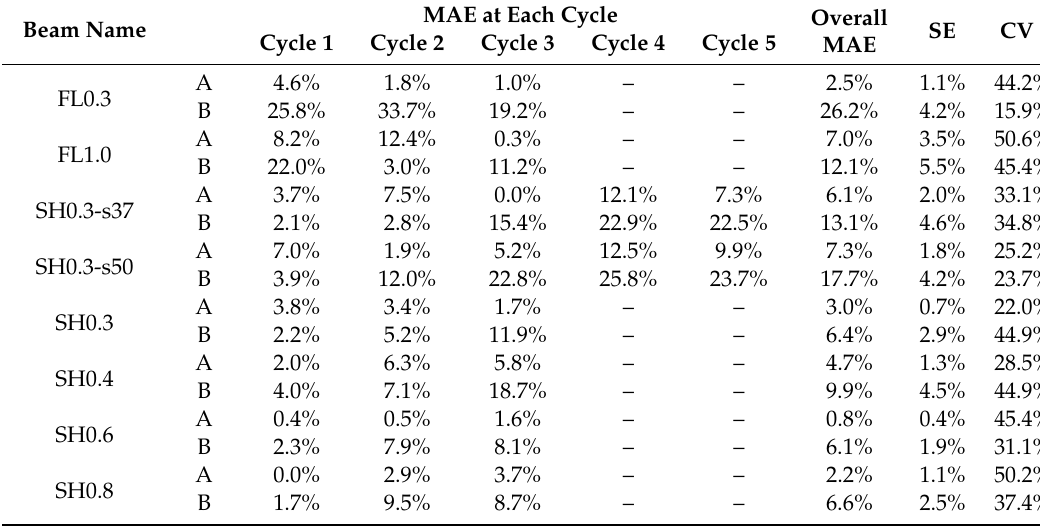
Table 8. Error calculation in the prediction of cyclic sti ff ness, K cyclic